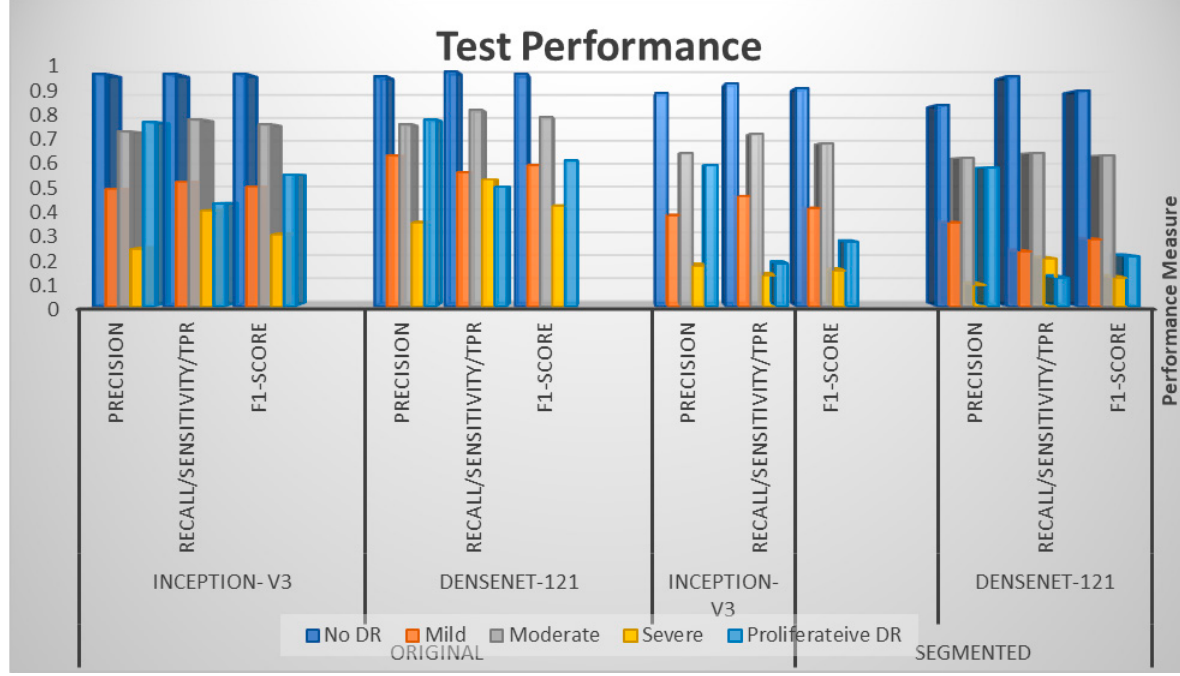
Figure 4. Test performances for Inception v3 and DenseNet-121.